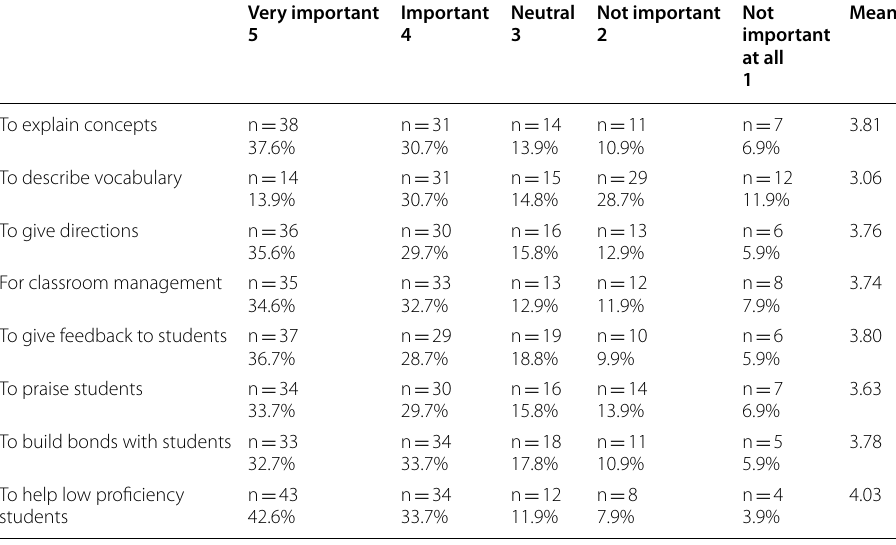
Table 3 Teachers’ attitudes towards the importance of their use of students’ native language(s)